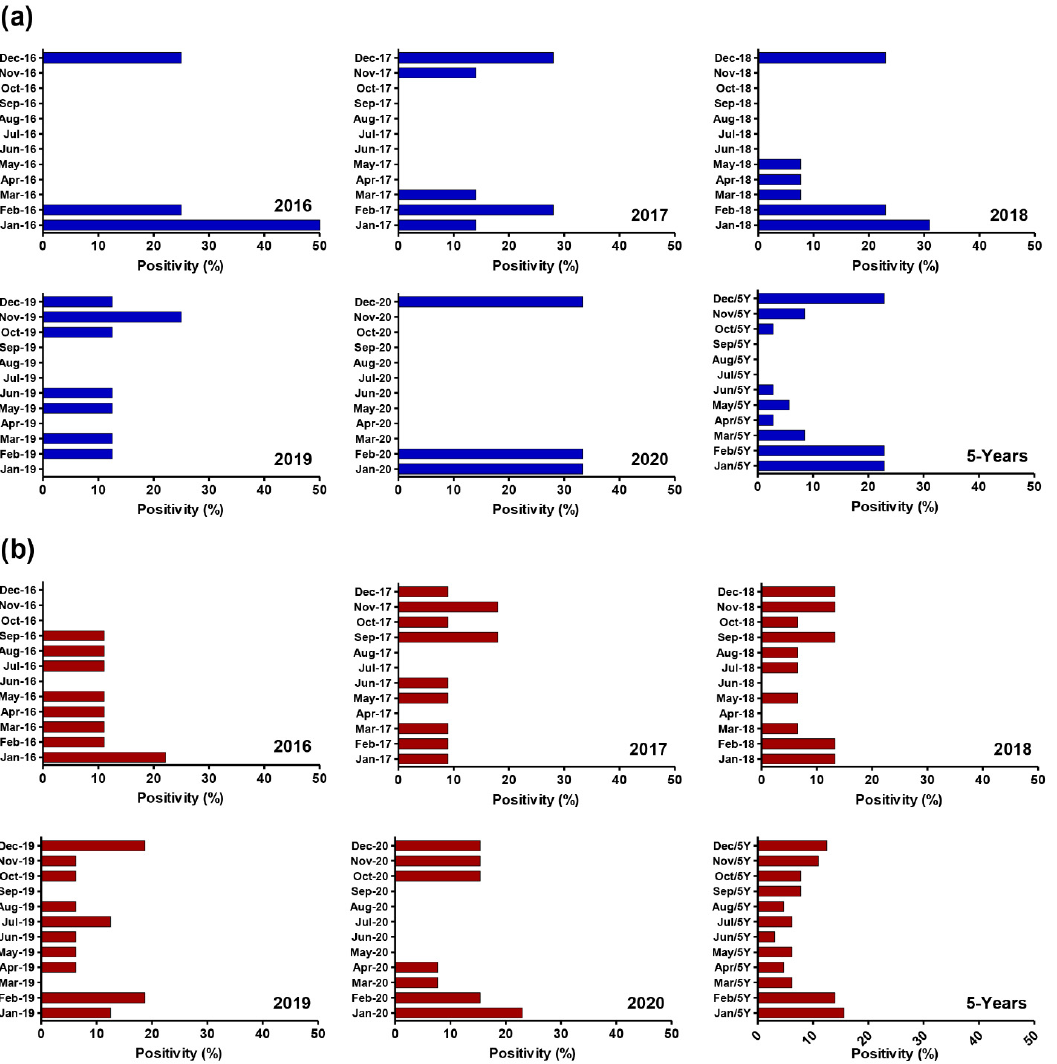
Figure 2. Monthly distribution of human adenovirus infections in both clinical and environmental samples in Egypt from 2016 to 2020. ( a ) Monthly Distribution of HAdV in clinical samples includes collectivity slide for 5-year positivity %; ( b ) Monthly Distribution of HAdV in Environmental samples includes collectivity slide for 5-year positivity %. HAdV levels in clinical samples peak mainly in December, January, and February, although HAds levels in environmental samples are observed throughout the year.